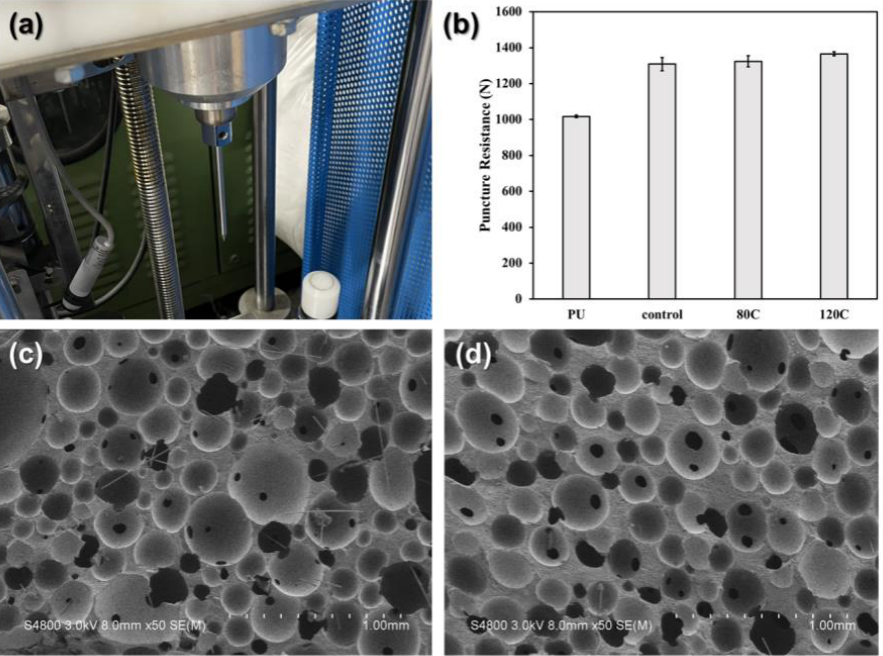
Figure 5. ( a ) The needle-like impactor for the dynamic penetration test and ( b ) the penetration re-